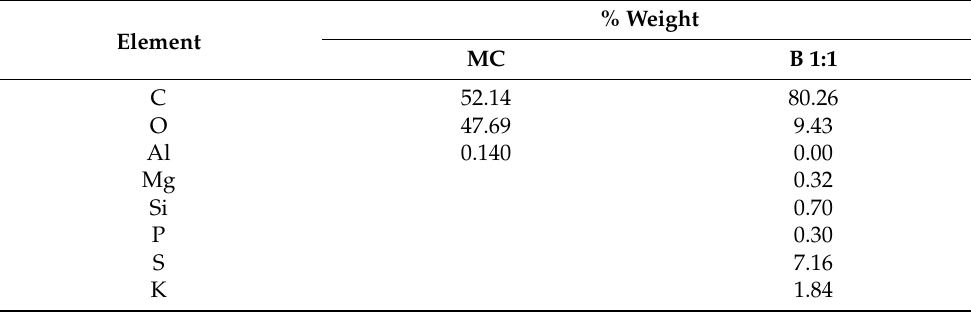
Table 1. Bio-adsorbent elementary composition determined from the EDS